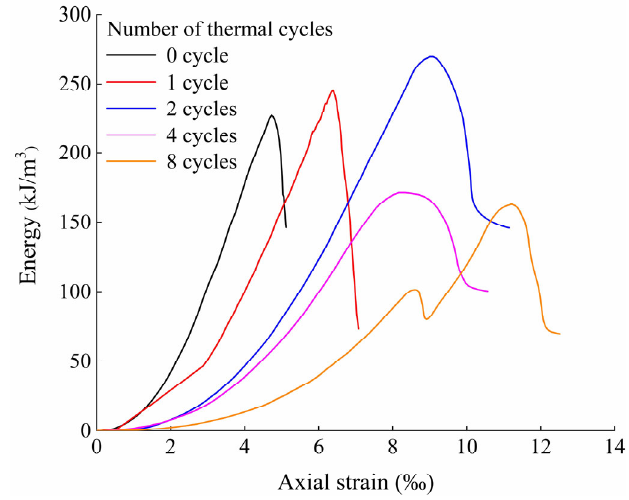
Figure 13. Variation in the elastic strain energy of marble with axial strain during different numbers of thermal cycles under 0 confining pressure.